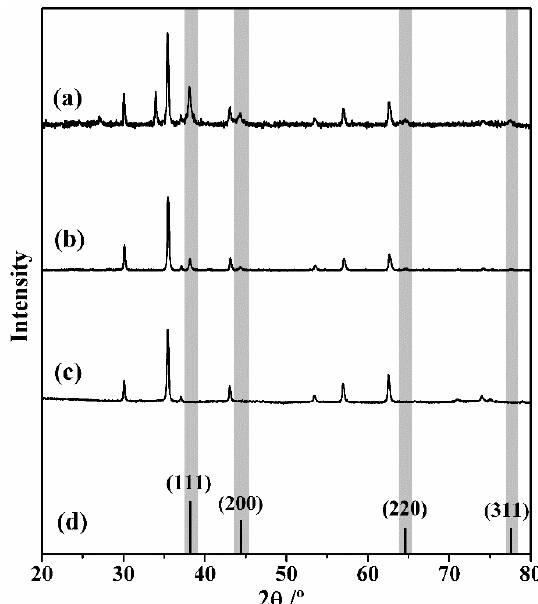
Figure 3. Powder XRD diffraction patterns of ( a ) MNP-AuNS NPs; ( b ) MNP-Au seeds; ( c ); Fe 3 O 4 NPs; and ( d ) reported reflexions for crystalline gold with fcc structure (JCPDS Card No. 04-0784).